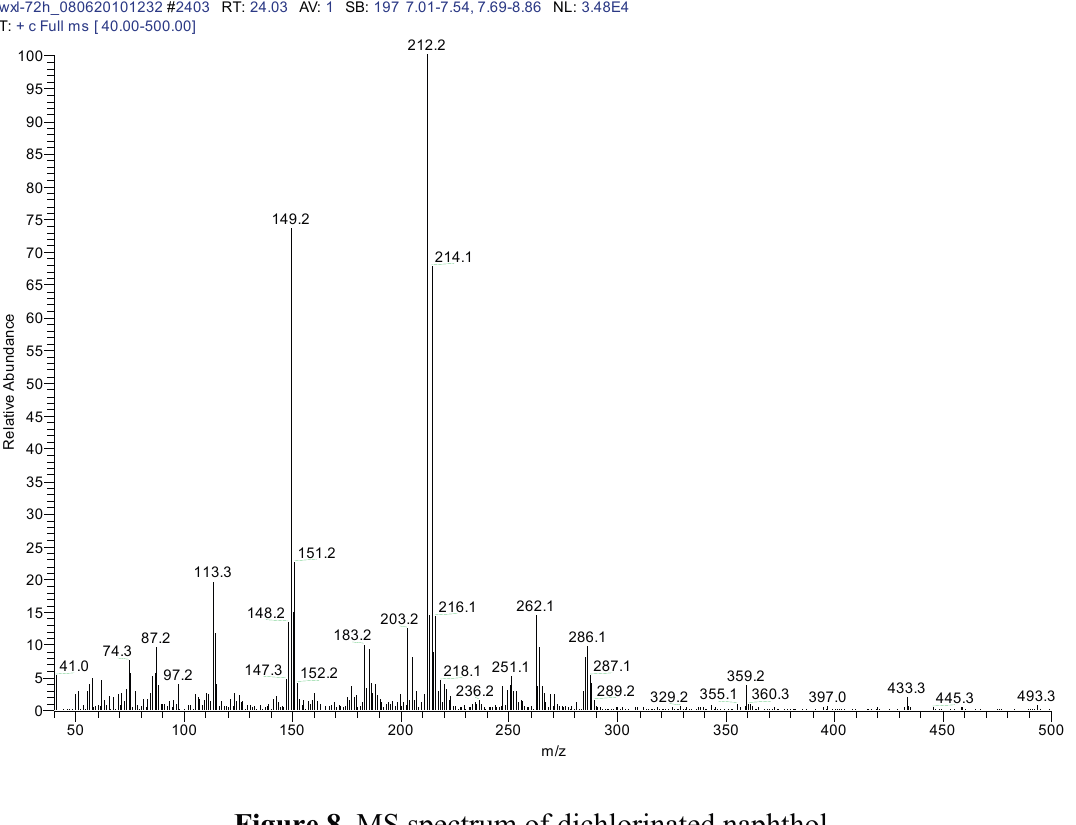
Figure 8. MS spectrum of dichlorinated